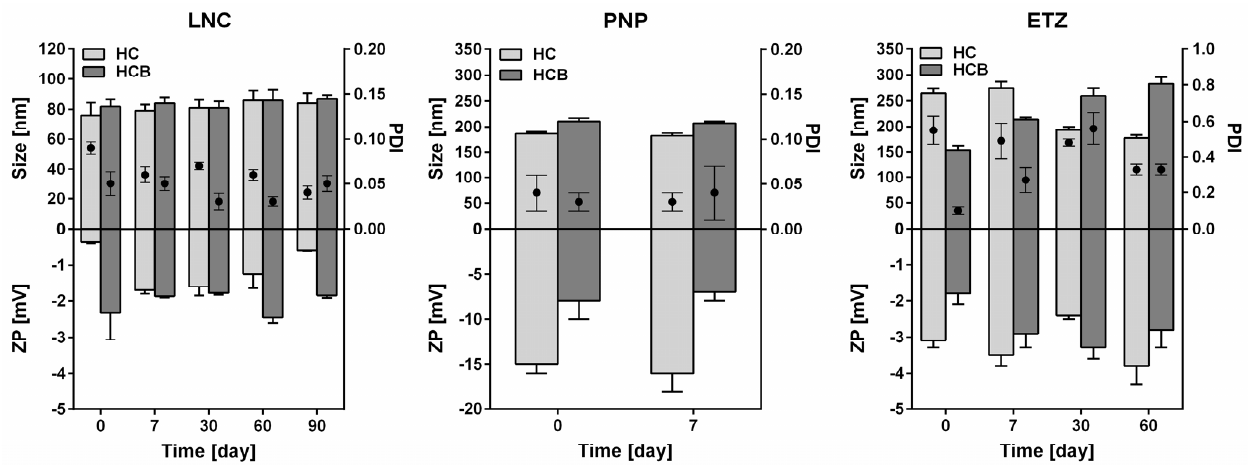
Figure 1. Particle size as the hydrodynamic diameter (bars), polydispersity index (PDI, scatter), and zeta potential (ZP, negative bars) of lipid nanocapsules (LNC), polymeric nanoparticles (PNP), and ethosomes (ETZ) containing 0.1% of hydrocortisone (HC) and hydrocortisone-17-butyrate (HCB; HCB-PNP contained 0.05% of HCB) measured on the day of preparation and consequently for following days. LNC and ETZ samples were stored at 25 °C. PNP were stored at 4 °C. n ≥ 6.